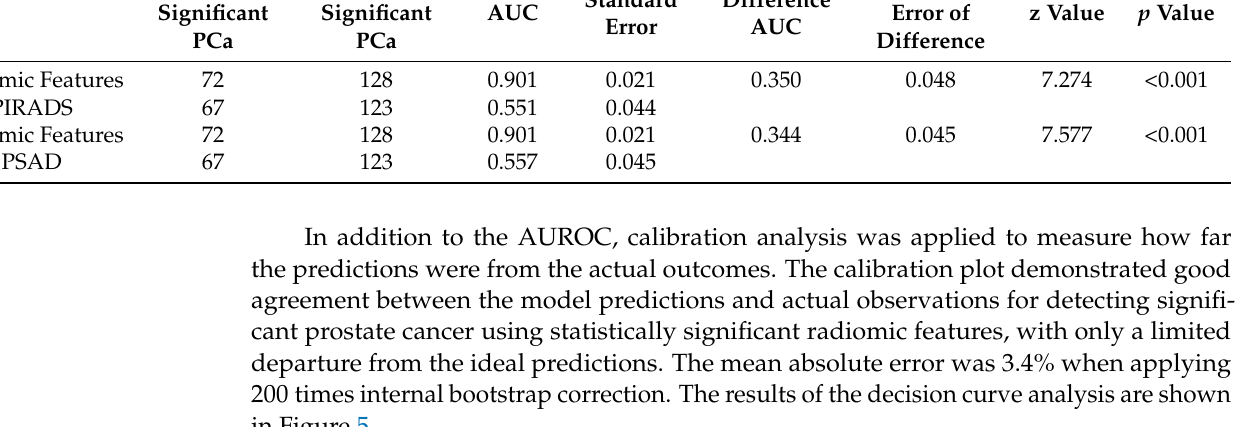
Figure 5. Receiver operating characteristics (ROC) curve and area under the curve (AUC) for model discriminative ability (the areas under the ROC are 0.551 for PIRADS, 0.901 for significant RF and 0.557 for PSAD).